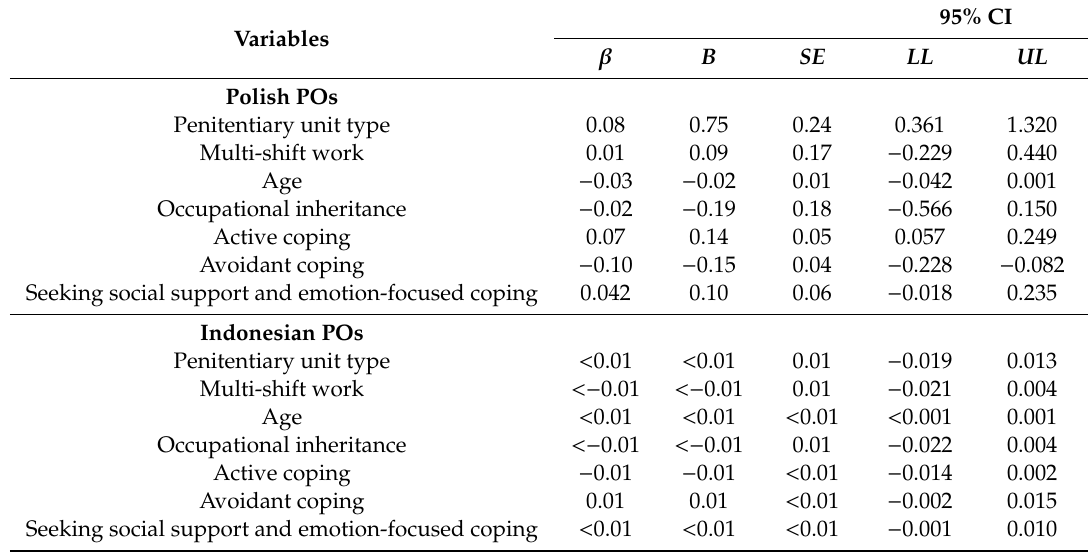
Table 5. Indirect e ff ects of subjective well-being in the explanatory model of work